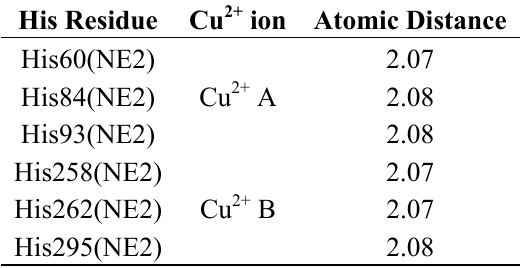
Table 4. Average distances between His residues and Cu 2+ cations in their respectively coordination sphere during MD simulations. All distances are calculated in